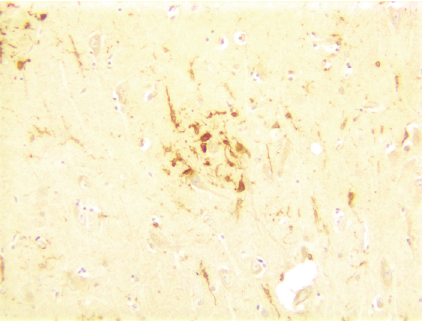
Figure 1: Activated microglia, overexpressing interleukin-1, within an A β plaque in Alzheimer brain. Immunohistochemistry using an antibody specific for IL-1 α